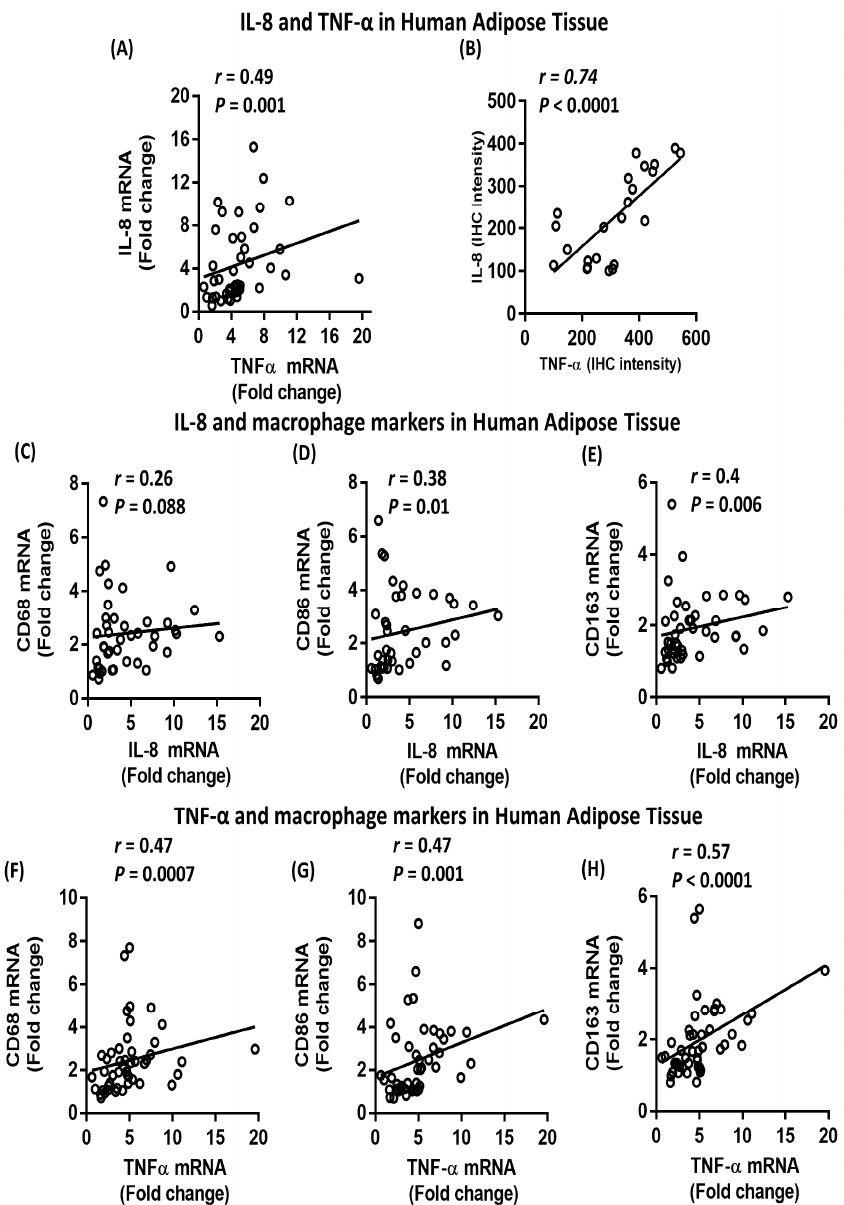
Figure 10. Association between IL-8, TNF- α and macrophage markers in human adipose tissue. Subcutaneous adipose tissue was obtained from individuals with normoweight, overweight or obesity. ( A , B ) Direct correlation between IL-8 and TNF- α at both the mRNA and protein level. ( C – E ) Direct correlation between IL-8 mRNA expression and CD68, CD86, and CD163. ( F – H ) Direct correlation between TNF- α and CD68, CD86 and CD163. The mRNA expression was detected by real-time RT-PCR and represented as fold change over controls. The protein expression was detected by immunohistochemistry and represented as staining intensity based on Aperio-positive pixel counts (Aperio software algorithm version 9.0). Correlation analysis was conducted using the non-parametric Spearman’s r test.